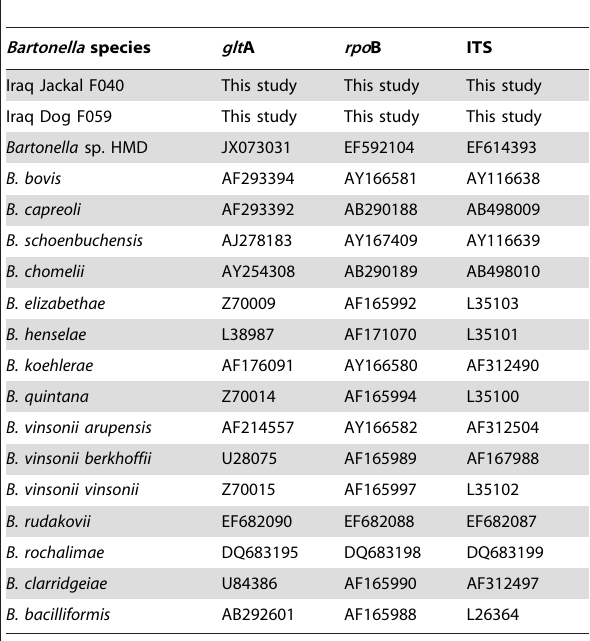
Table 1. GenBank sequences used for Figure